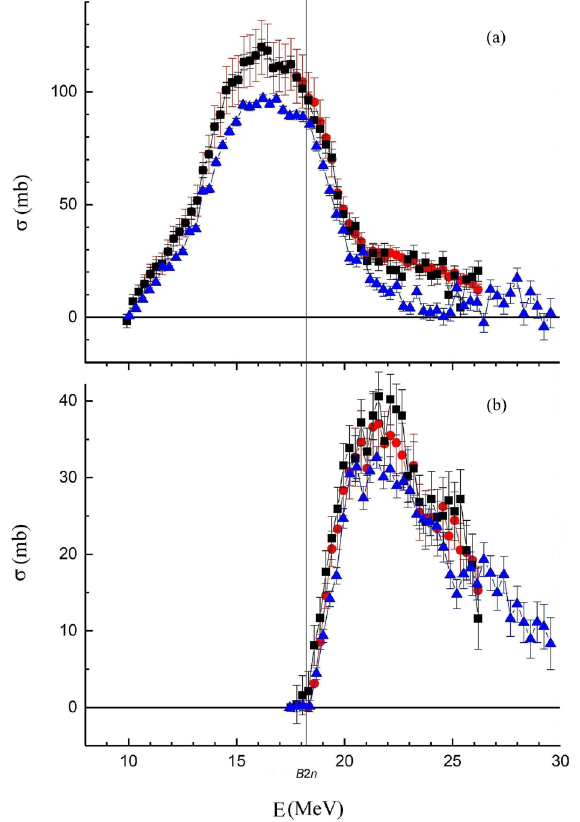
Figure 2. Evaluated ([10], circles) and experimental (Livermore [21], triangles and Saclay [22], squares) cross sections for 181 Ta: /σ int for 181 Ta Table 1. Ratios of integrated cross sections σ int exp e v al obtained up to energy E int = 25 MeV.